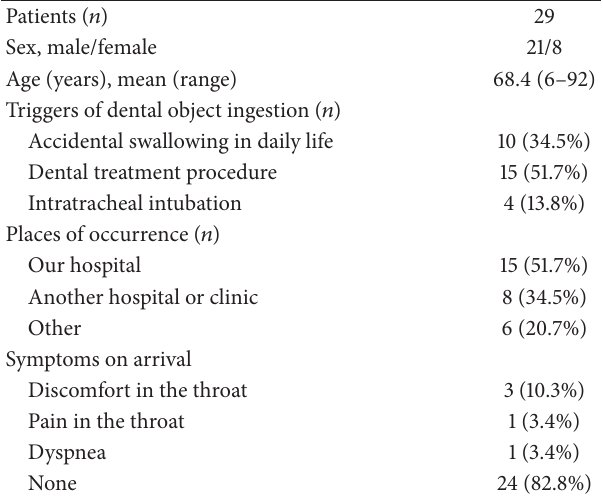
Table 1: Patients’ characteristics and clinical